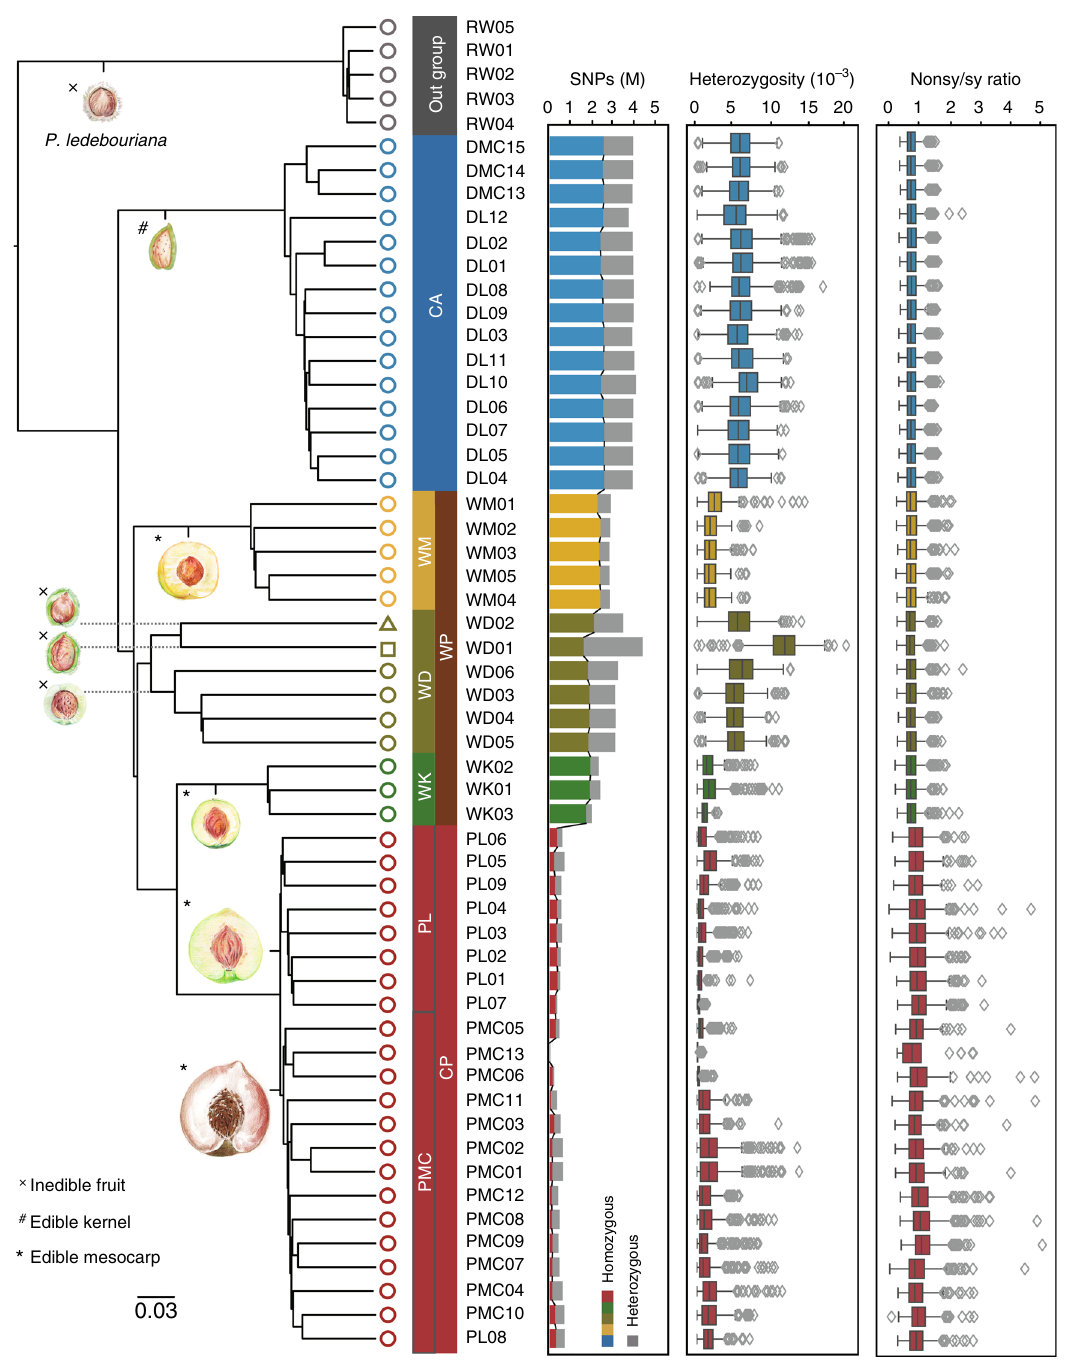
Fig. 2 Neighbor-joining phylogenetic tree of the 51 Amygdalus accessions. The NJ tree altogether with the number, heterozygosity, and Nonsy/sy ratio of SNPs for all the Amygdalus accessions were shown. The NJ tree was generated using P. ledebouriana as the outgroup based on an analysis of a total of 3,909,617 whole-genome SNPs (maf<5%, call rate>90%). Horizontal lines at the center of each box show median values. Bounds of each box show the quartiles. The upper whisker extends to last datum less than Q3 + 1.5*IQR, where IQR is the interquartile range (Q3 - Q1). The lower whisker extends to last datum larger than Q3 - 1.5*IQR. The typical fruit morphology and edibility of all the Amygdalus species and the outgroup species in this study are shown. Fruit images were created by Yang Yu and Shan